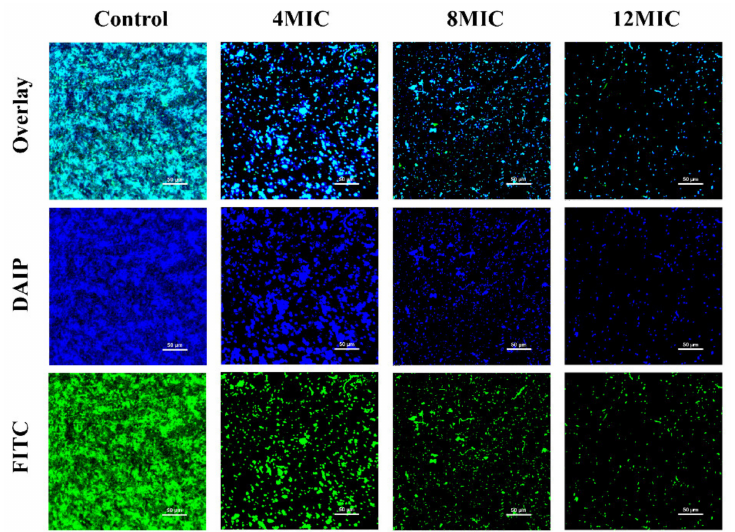
Figure 11. CLSM observations (400 × magnification) of OEO on the E. faecalis ATCC 29212